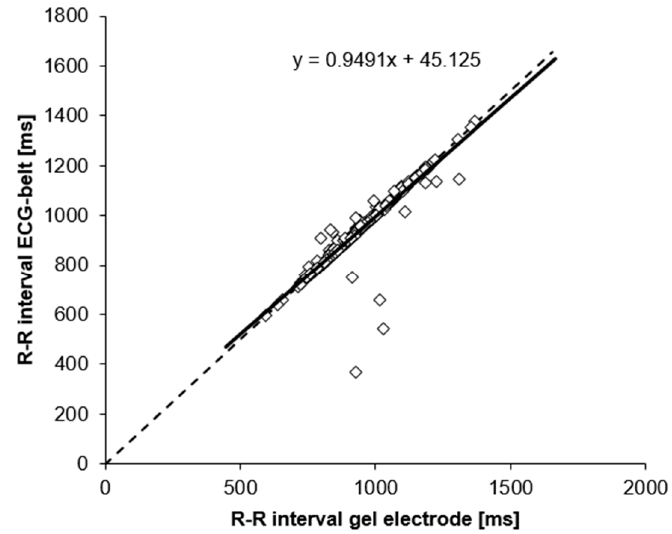
Figure 3. Line of identity (dashed line) for RR-intervals measured using gel electrodes and the ECG-belt. Solid line, regression line incl. fit equation.